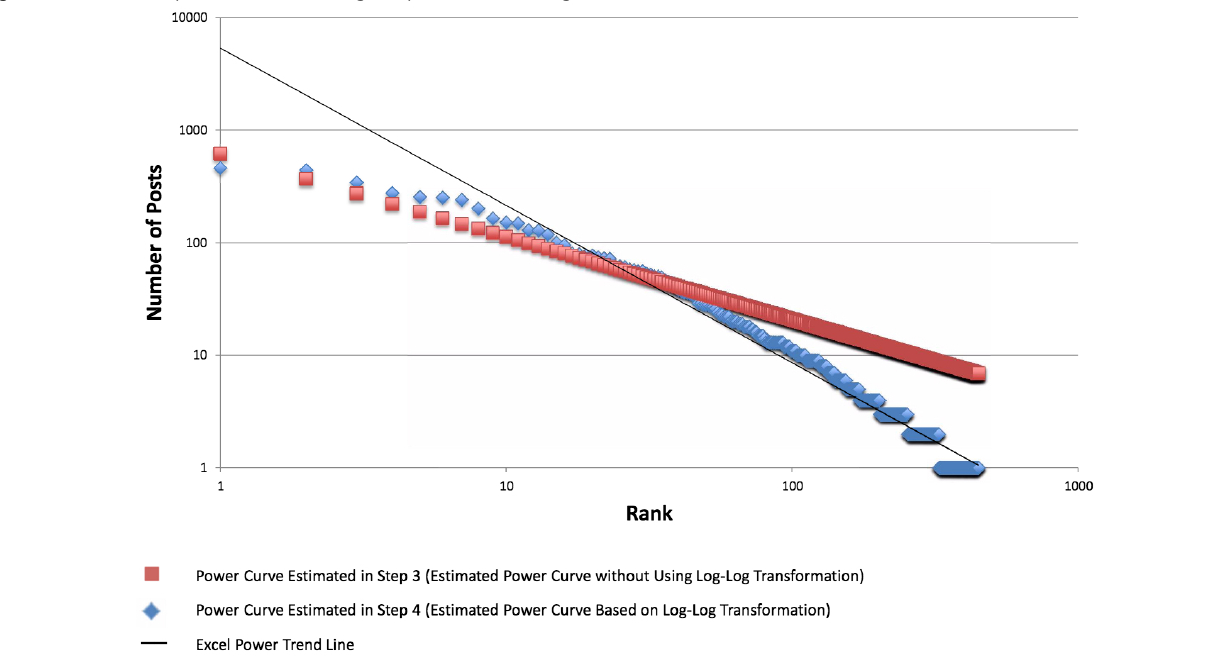
Figure 4. Alcohol Help Center actor ranking and power curve raking with trendline and R2